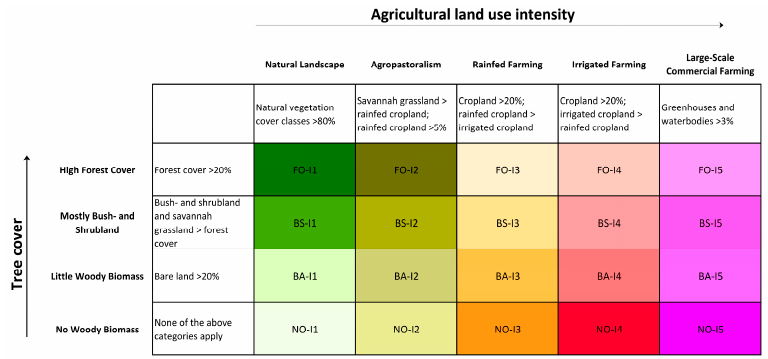
Figure 2. Landscape types categorized by land use intensity and woody biomass cover (adapted from Zaehringer et al. [65]). The five binary maps representing the five intensity categories are largely complementary, but some overlaps nonetheless exist. For this reason, we combined them according to their intensity levels, with the map showing the most intensive category at the top and the one showing the least